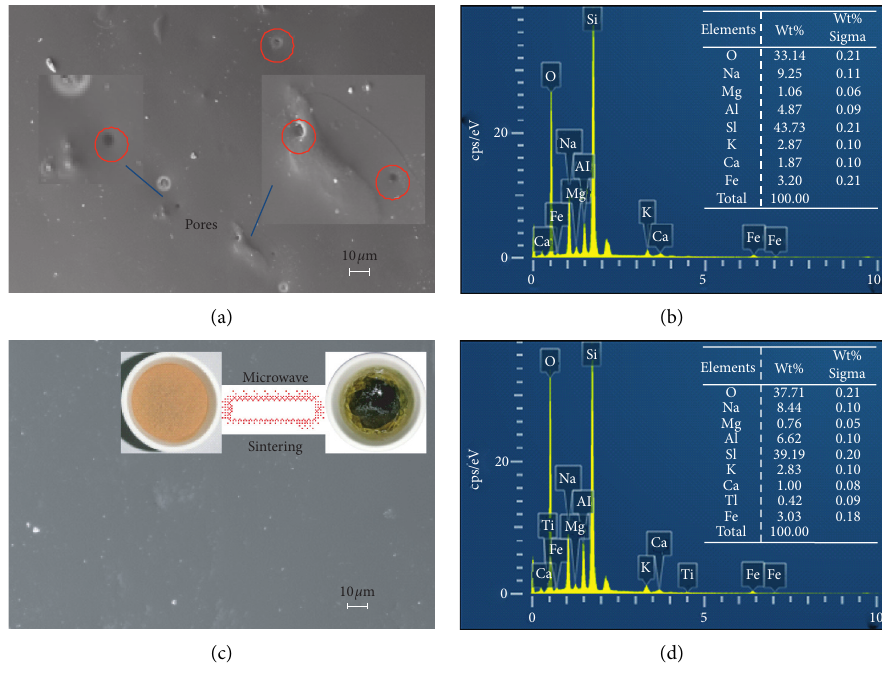
Figure 5: SEM image and EDS spectra of solidified forms at 1000 ° C (a, b) and 1200 ° C (c, d), respectively.